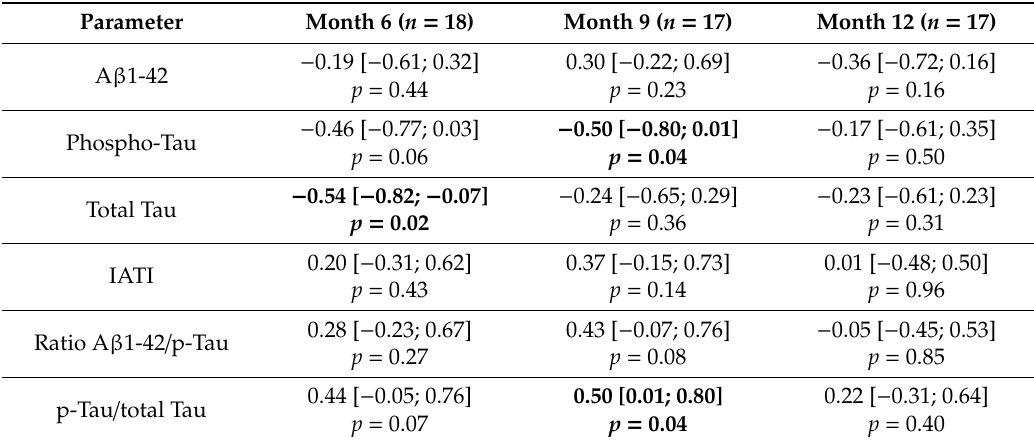
Table 4. Evaluation of biomarkers as prognostic for ALSFRS-R variation over 6, 9, and 12 months in relation to the baseline value of